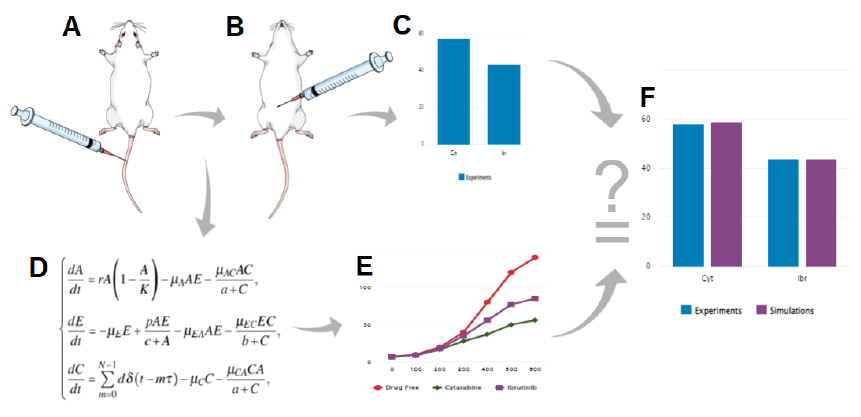
Figure 1. Schematic representation of the workflow used in this study. ( A ), injection of A20 leukemic cells; ( B ), drug treatment; ( C ), in vivo examination of the effect of a drug on cancer cell viability; ( D ), development of the mathematical model; ( E ), numerical simulations of the model; F, validation of the model by correlation of experimental results and